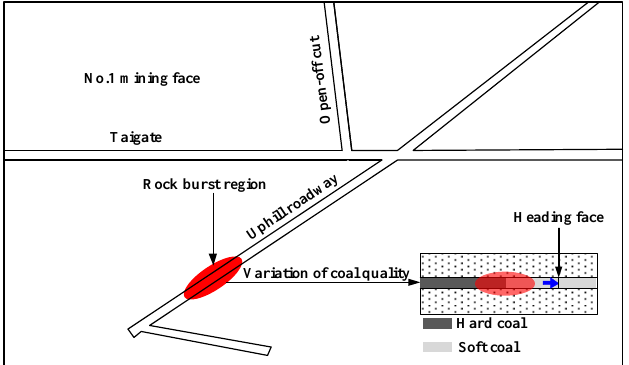
Figure 7. Rock burst region in the No. 1 mining face.